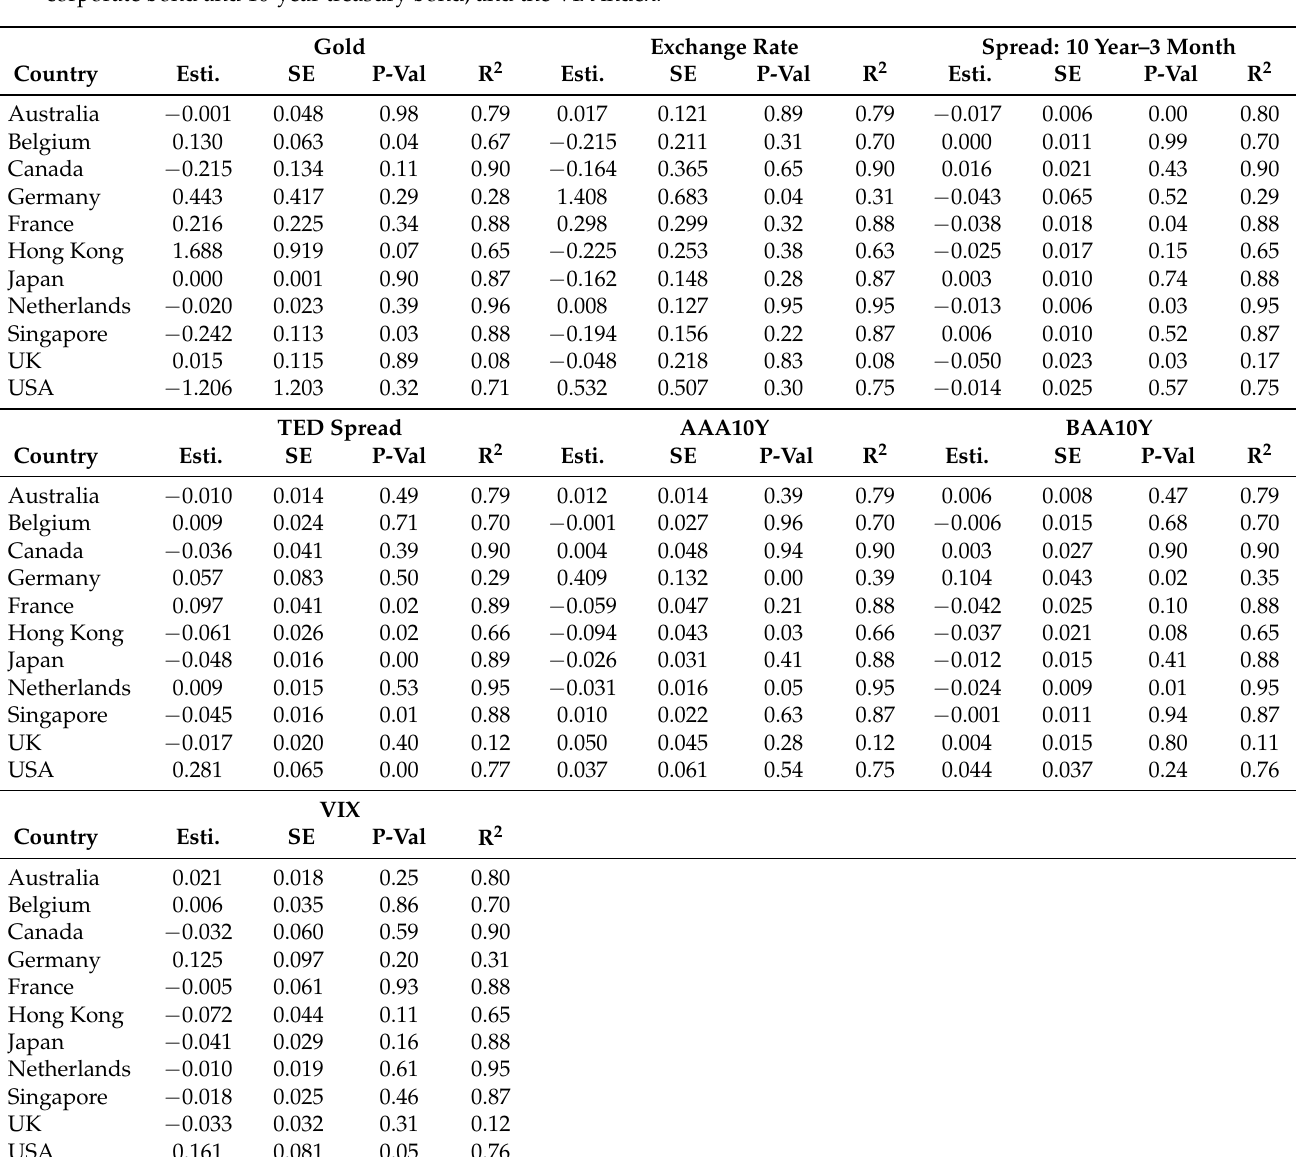
Table 5. The US financial market conditions and time-varying impact of LSAP shocks. The table presents the impact of the US financial market conditions on time-varying response of international REITs to LSAP shocks using the OLS model. Given the construction of the TVP model, each regression includes a lag of the dependent variable and a constant. The financial market condition measures include changes in gold prices, exchange rates, US treasury spread between 10-year and 3-month maturity, TED spread, spread between AAA corporate bond and 10-year treasury bond, spread between BAA corporate bond and 10-year treasury bond, and the VIX